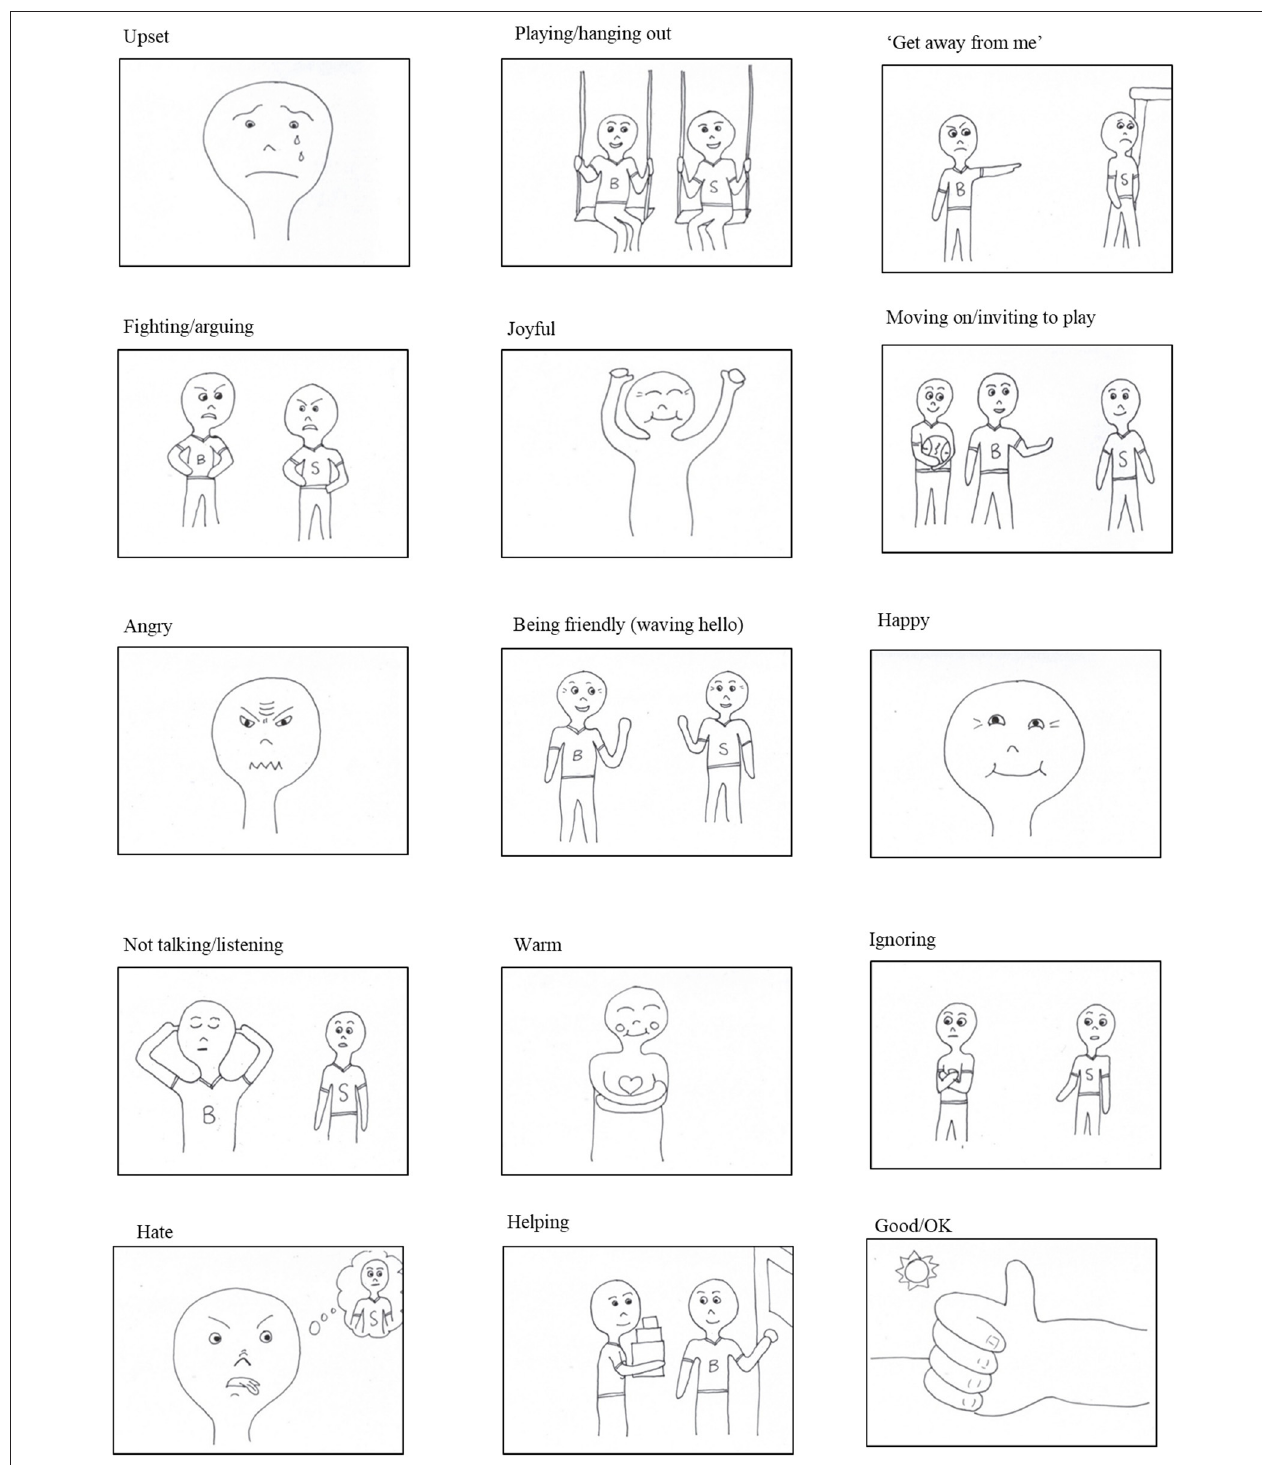
FIGURE 1 | Illustrations included in the final version of the Children’s Forgiveness Card Set. Each illustration is presented on a separate card, depicted above a 10 centimeter line with a cross illustrated at the left hand (0cm) anchor and a tick illustrated at the right hand (10cm) anchor of the line.